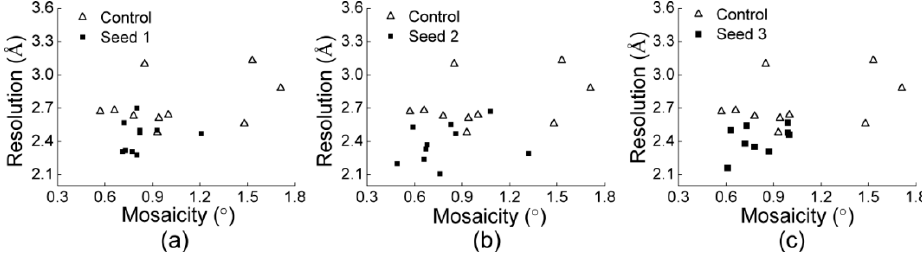
Figure 7. Combination of the resolution limit and mosaicity data for the thaumatin crystals in the same Figure. ( a ) in the presence of seeds 1, ( b ) in the presence of seeds 2, ( c ) in the presence of seeds 3.